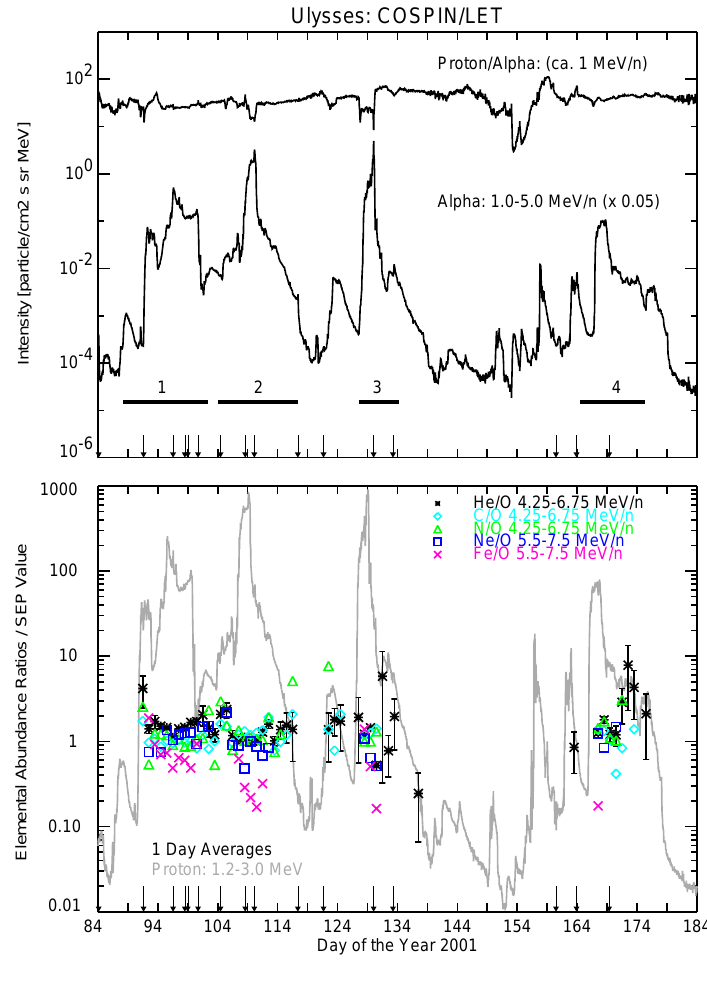
are plotted for two energy ranges (left and right) and five dif- ferent elemental composition ratios (panels 1–5), resulting in 10 panels. The left column contains averages based on ob- servations in the low energy range (4 . 25 MeV/n–7 . 5 MeV/n) and the right column contains the values of the high energy range (13 MeV/n–30MeV/n). The two horizontal lines mark the reference value for an SEP population (i.e. unity), and a CIR population for the corresponding element, i.e. CIR/SEP, as listed in the last six rows of the Tables 1 and 2. In panels 1 and 2 in the left column, (He/O and C/O), the two dashed horizontal reference lines are well